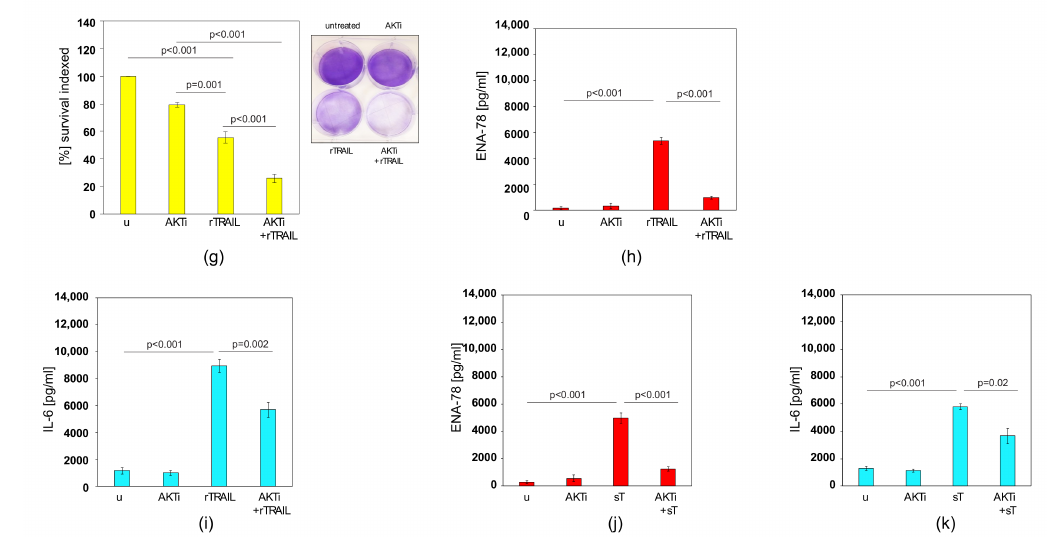
Figure 6. AKTi can sensitise prostate cancer cells to TRAIL and block cytokine production. ( a ) Apoptosis was measured in PC3 cells that were treated with increasing concentrations of PI3Ki or AKTi and co-treated with increasing concentrations of rTRAIL. DMSO is a vehicle control. ( b ) Apoptosis was measured in LNCaP cells that were treated with increasing concentrations of PI3Ki or AKTi and co-treated with increasing concentrations of rTRAIL. DMSO is a vehicle control. ( c ) Apoptosis was measured in C4-2B cells that were treated with increasing concentrations of PI3Ki or AKTi and co-treated with increasing concentrations of rTRAIL. DMSO is a vehicle control. ( d ) Apoptosis measurement of LNCaP cells mixed with control MSCs (ctrl), MSC.FL-TRAIL (FL) or MSC.sTRAIL (sT) at di ff erent ratios (50:1; 100:1) either with or without AKTi. ( e ) LNCaP cells were grown as 3D spheroids and then treated with supernatants from control MSCs (ctrl), full-length TRAIL (FL) MSCs and sTRAIL (sT) MSCs plus AKTi, before cell viability was assessed. ( f ) LNCaP cells were grown as spheroids in Matrigel and then treated with control MSCs (ctrl), MSC.FL-TRAIL (FL) and MSC.sTRAIL (sT) plus AKTi, before cell viability was assessed. The right panel shows representative images. Spheroids are indicated by yellow arrows, MSCs by black arrows. Scale bar is 30 µ m. ( g ) Measurements of survival of untreated PC3 cells (u), PC3 cells treated with AKTi, treated with rTRAIL or treated with a mix of AKTi and rTRAIL. A representative image of these measurements is shown on the right side. ( h ) CXCL5 / ENA-78 ELISA results of supernatants of untreated PC3 cells (u), PC3 cells treated with AKTi, treated with rTRAIL or treated with a mix of AKTi and rTRAIL. ( i ) IL-6 ELISA results of supernatants of untreated PC3 cells (u), PC3 cells treated with AKTi, treated with rTRAIL or treated with a mix of AKTi and rTRAIL. ( j ) CXCL5 / ENA-78 ELISA results of supernatants of untreated PC3 cells (u), PC3 cells treated with AKTi, treated with sTRAIL (sT) from MSCs or treated with a mix of AKTi and sTRAIL (sT). ( k ) IL-6 ELISA results of supernatants of untreated PC3 cells (u), PC3 cells treated with AKTi, treated with sTRAIL (sT) or treated with a mix of AKTi and sTRAIL (sT). Values represent mean ±